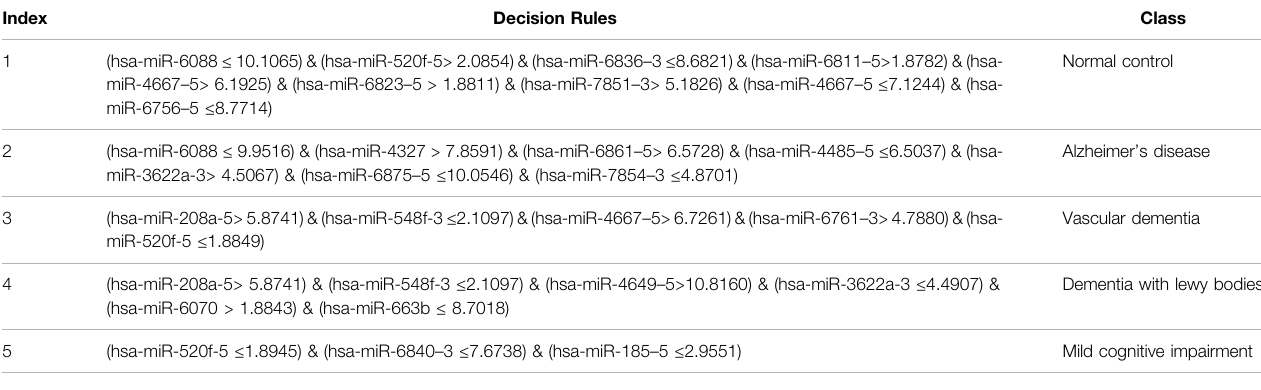
TABLE 4 | Some important rules extracted by the optimal PART classi fi er under the mRMR feature list.